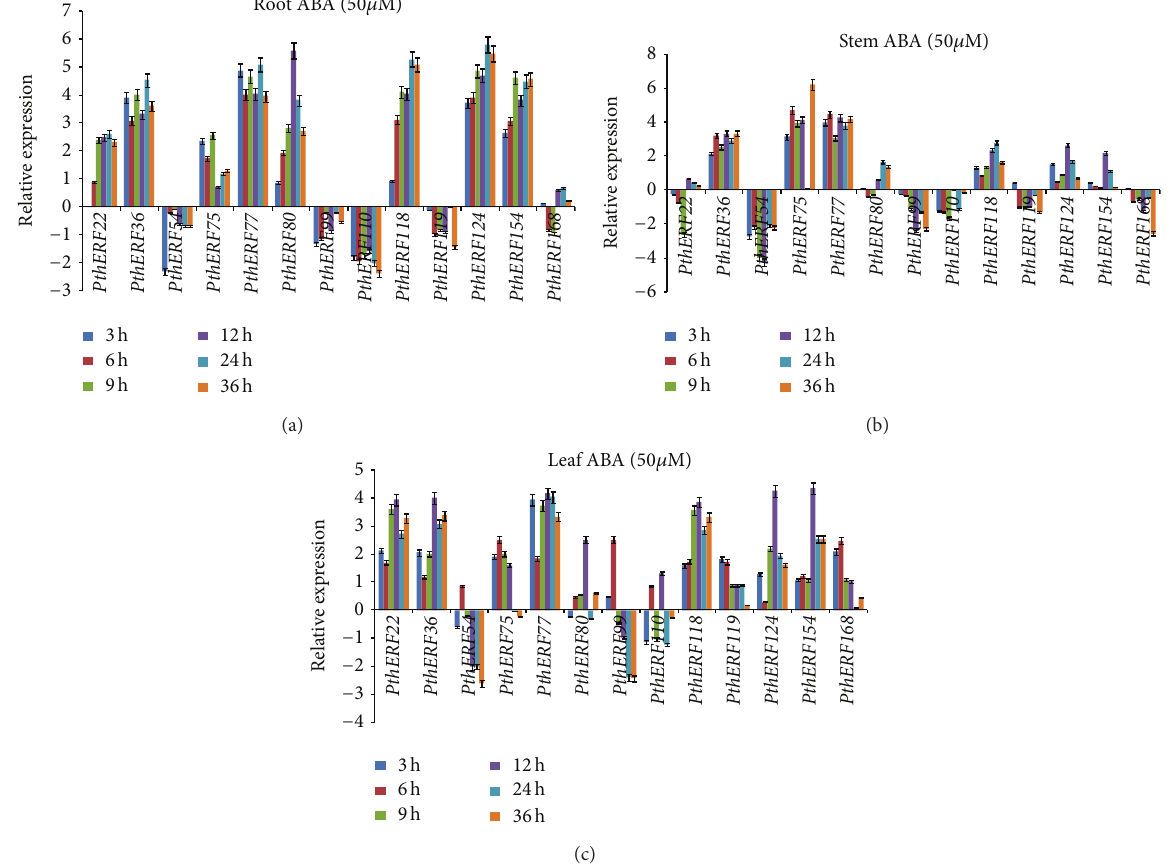
Figure 5: Spatial-temporal expression of 13 PthERFs under ABA treatment in different tissues. Relative expression level was log 2 transformed: > 0: upregulation; =0: no change in regulation; < 0: downregulation; (a) in roots; (b) in stems; (c) in